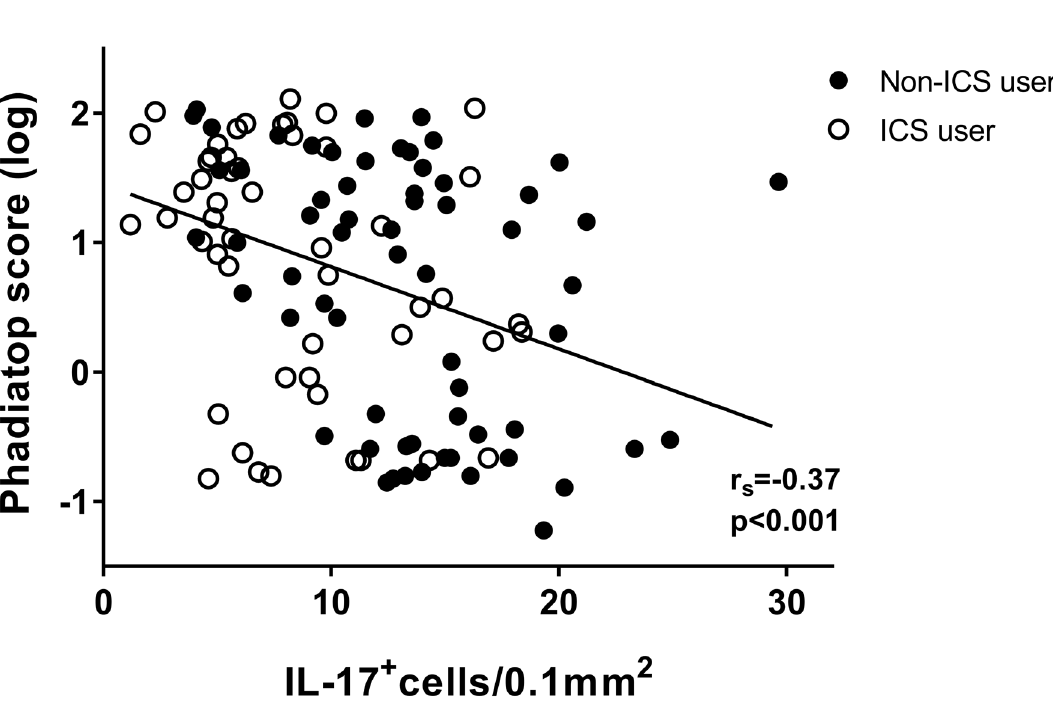
Fig 2. Negative correlation between the number of IL-17 + cells in the submucosa of bronchial biopsies and serum specific IgE (Phadiatop) from asthmatics (rs = -0.37; P < 0.001).